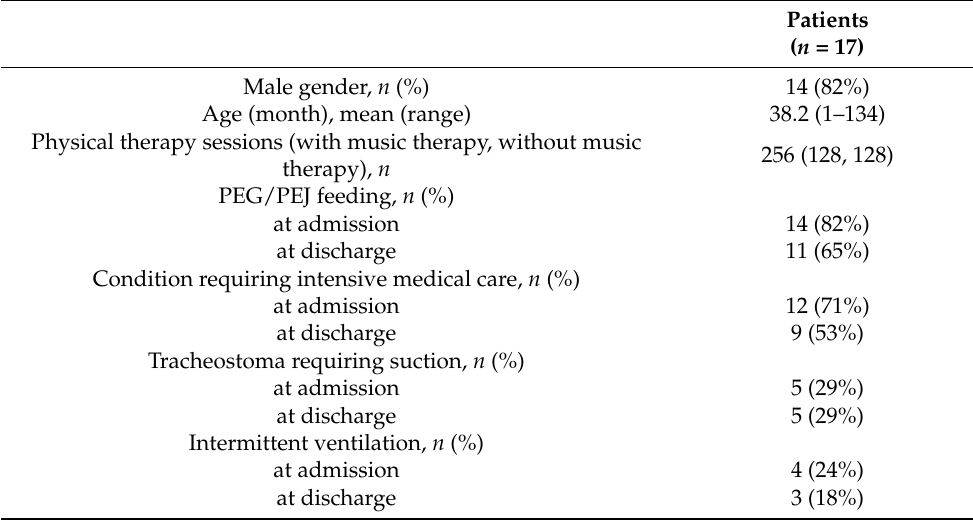
Table 1. Clinical characteristics of the